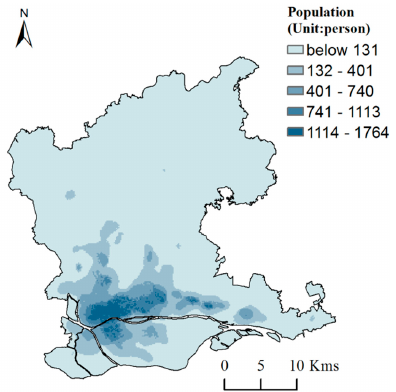
Figure 5. Simulation result by using global random forest regression model.